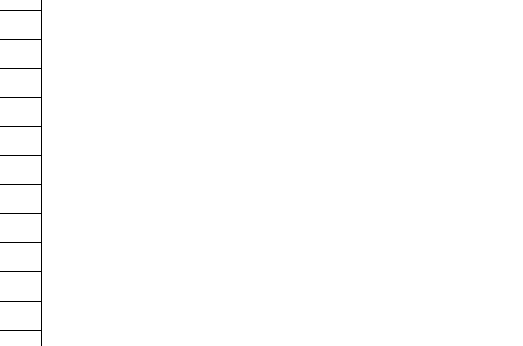
Kinetic model Parameters value